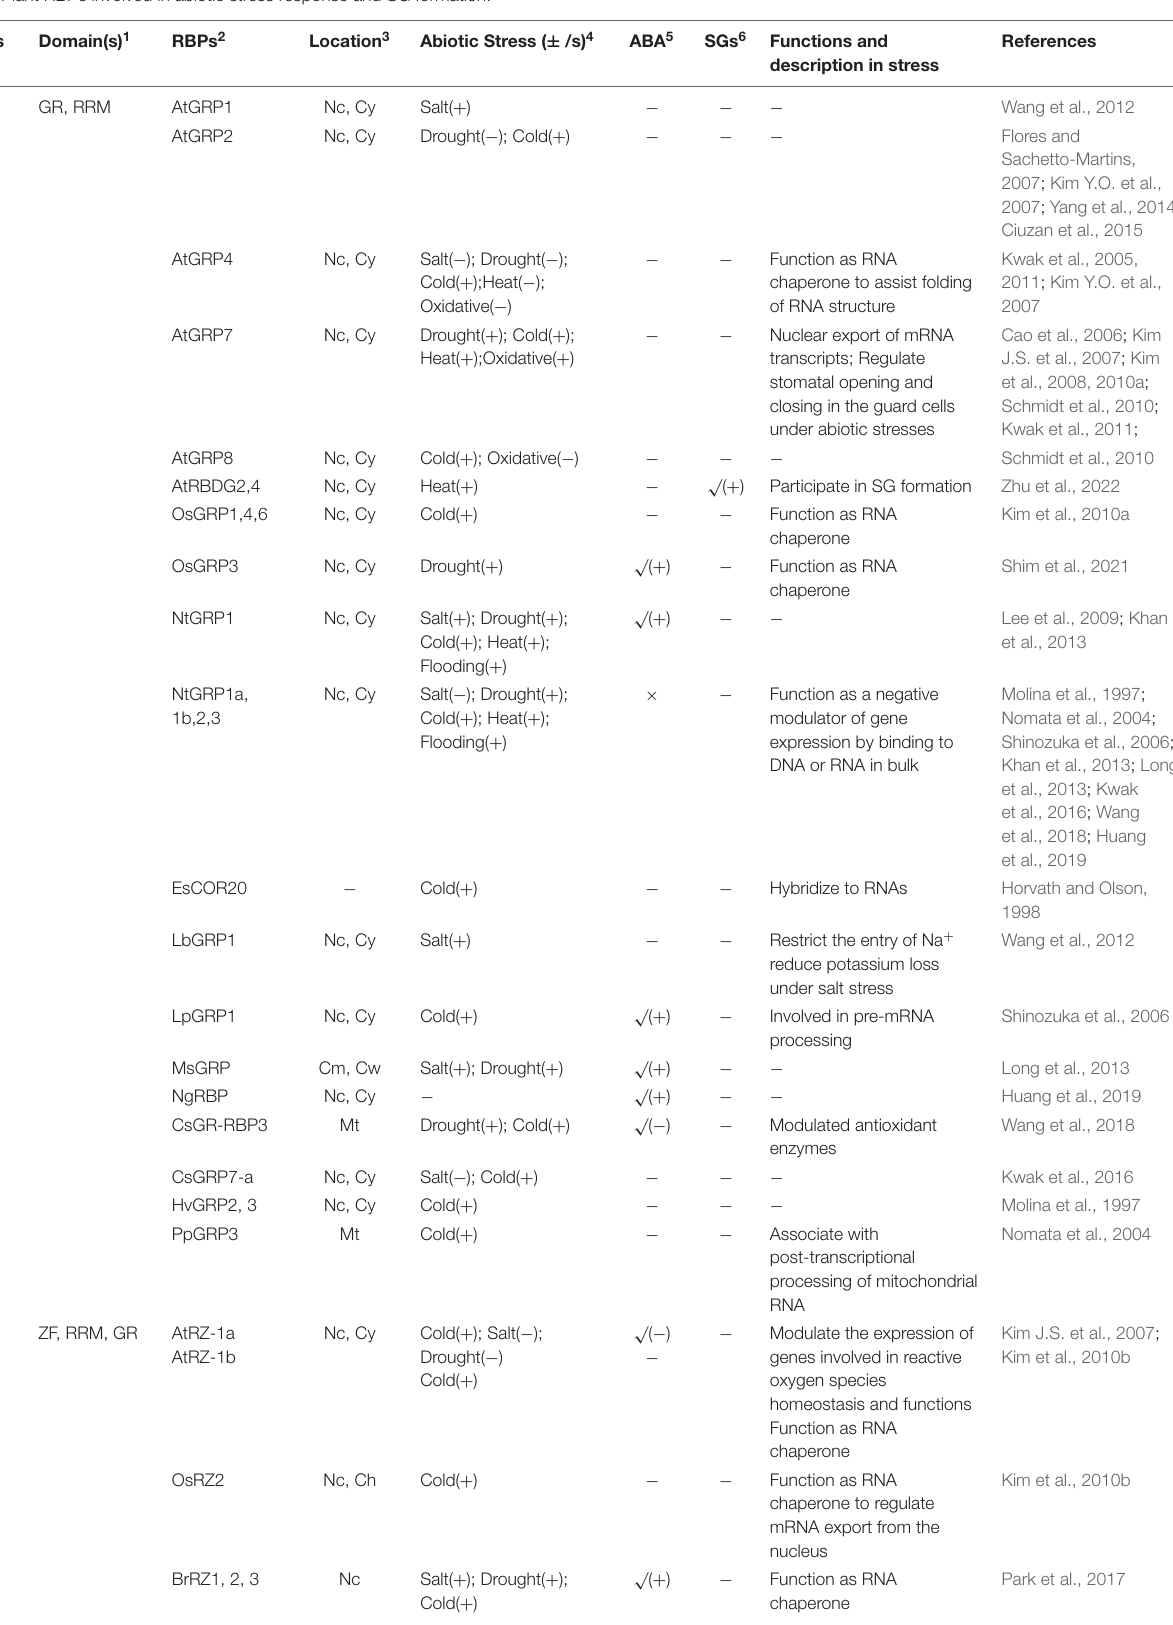
TABLE 1 | Plant RBPs involved in abiotic stress response and SG